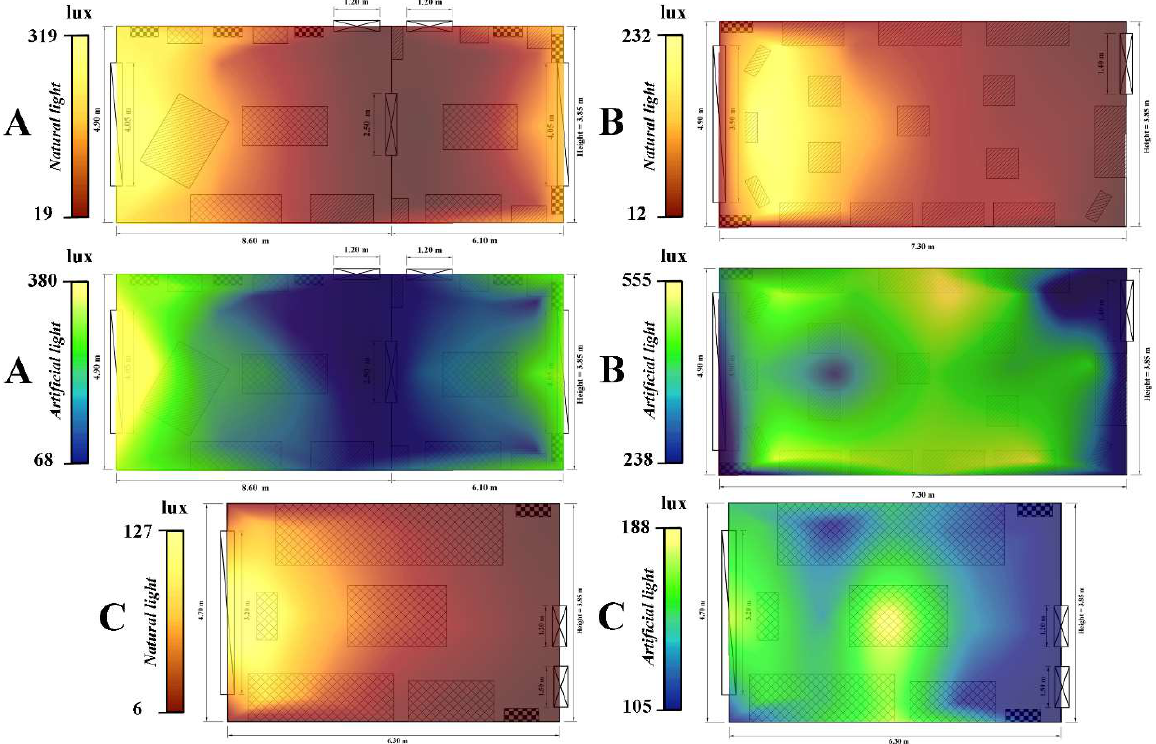
Figure 6. Spatial distribution of brightness (both natural light–NL and artificial light–AL) within the three analyzed rooms of the Darvas-La Roche House (( A )—The great hall–1st floor; ( B )—Exhibition hall–Ground floor; ( C )—Bedroom–1st floor).